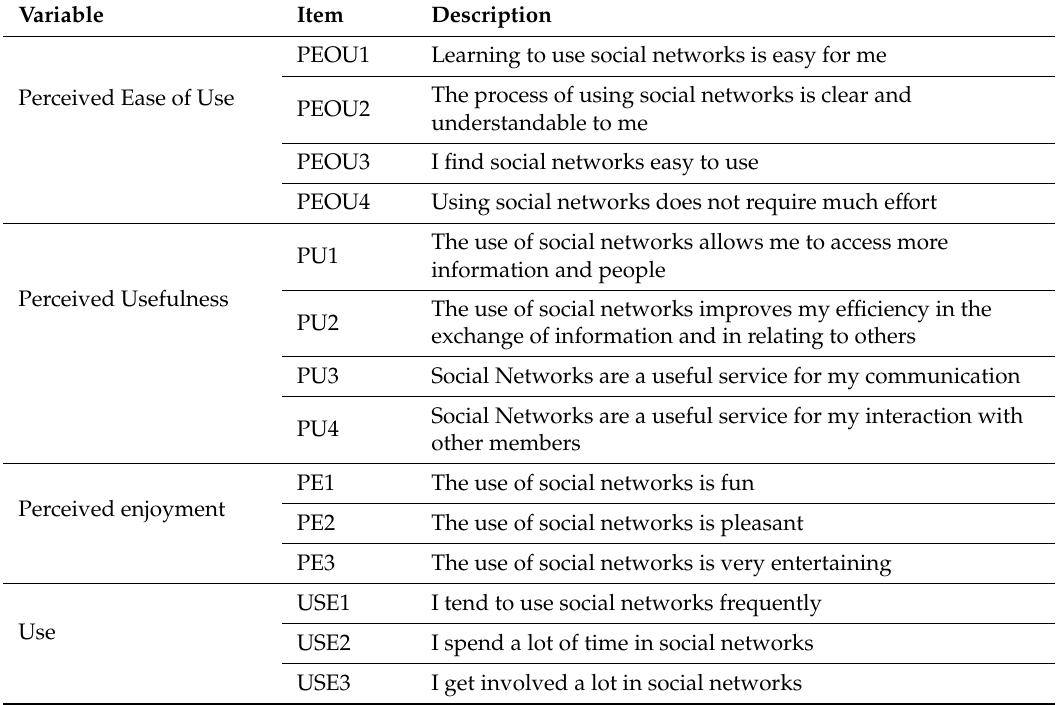
Table 1. Items used to measure the